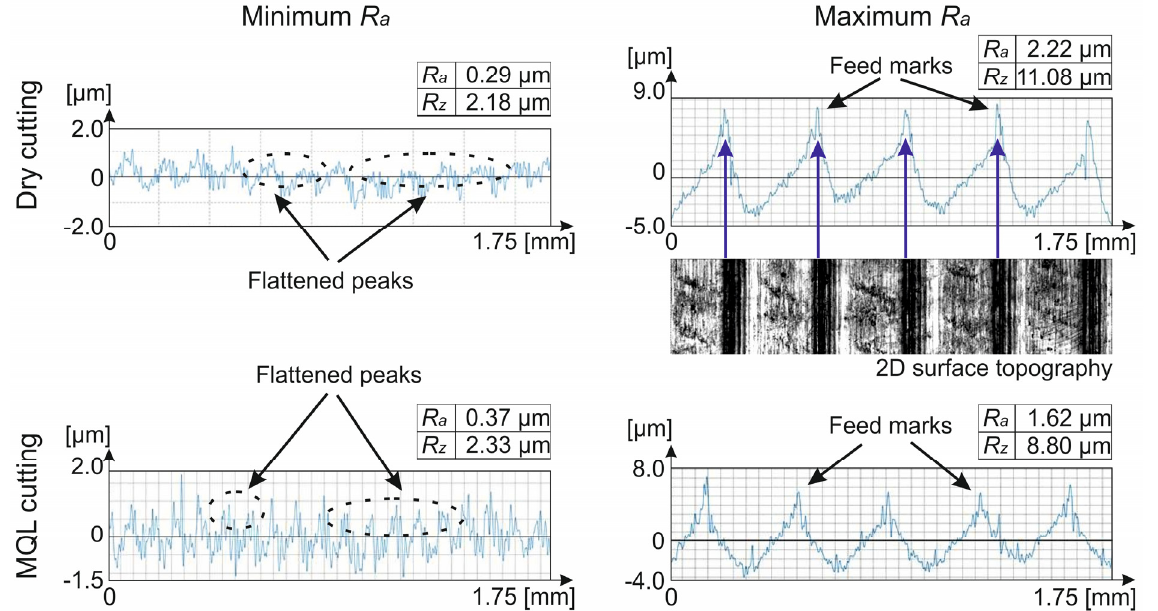
Figure 2. Surface roughness profiles of Ti6Al4V alloy after finish turning.